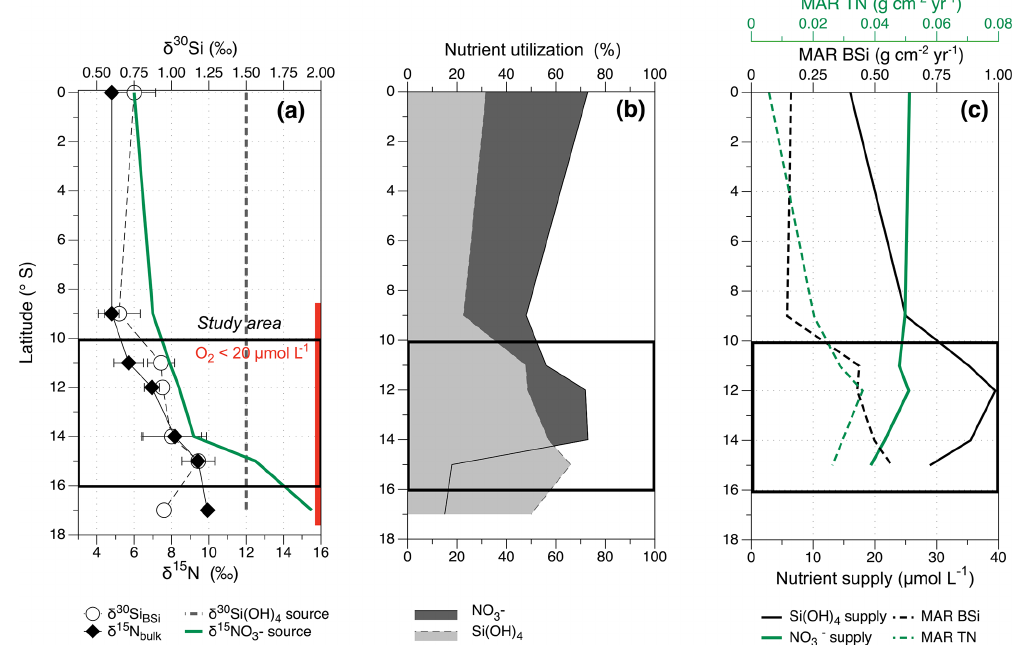
Figure 2. Latitudinal overview of present day (a) mean δ 15 N bulk (‰, black diamonds, 2SD error bars) and δ 30 Si BSi (‰, white circles, 2SD error bars), the dashed black line indicates the subsurface δ 30 Si ( OH ) 4 source value of 1.5‰, the green solid line marks the δ 15 NO − source value, increasing southwards from 6‰ (0–8 ◦ S), to about 8‰ (10–12 ◦ S) and 12.5‰ (15 ◦ S). The red bar indicates the area of suboxic conditions in subsurface waters. The black rectangle marks the study area for downcore reconstruction (see also Fig. 1). (b) Nutrient utilization for NO − (%, dark grey area) and Si ( OH ) 4 (%, dashed area). (c) MAR TN (gcm − 2 yr − 1 ), MAR BSi (gcm − 2 yr − 1 ; for calculation 3 see Sect. 2.6) and the nutrient supply (modified following Mollier-Vogel et al., 2012 and Ehlert et al.,